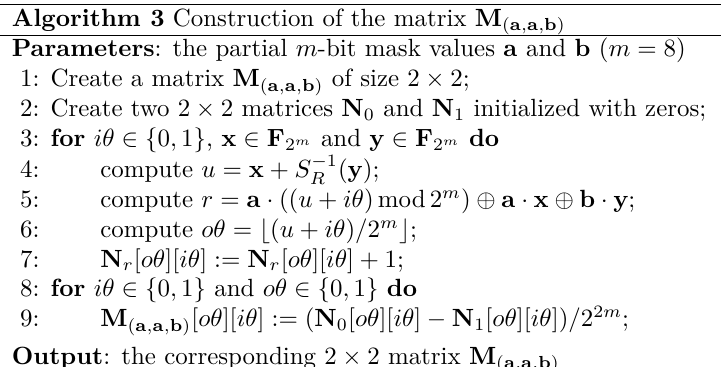
Algorithm 3 Construction of the matrix M